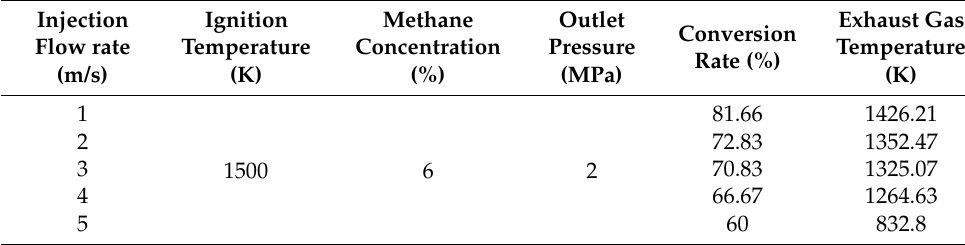
Table 5. Simulation parameters of the influence of injection rate on conversion rate and exhaust gas temperature at 2 MPa.